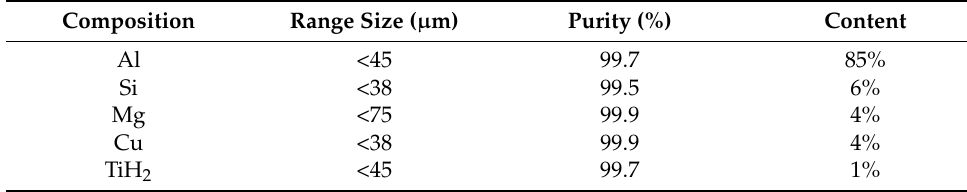
Table 1. Elemental composition of mixed powders